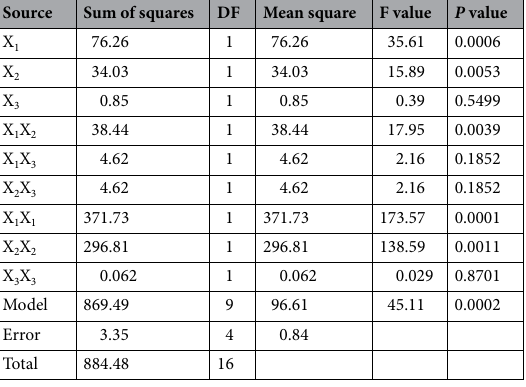
Table 2. Analysis of variance (ANOVA) for the fitted quadratic polynomial model. P Value < 0.05 indicates the model terms are significant.